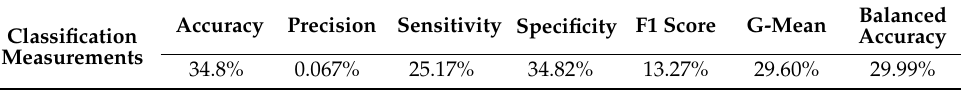
Table 16. Classification metrics for DRL on imbalanced CCF